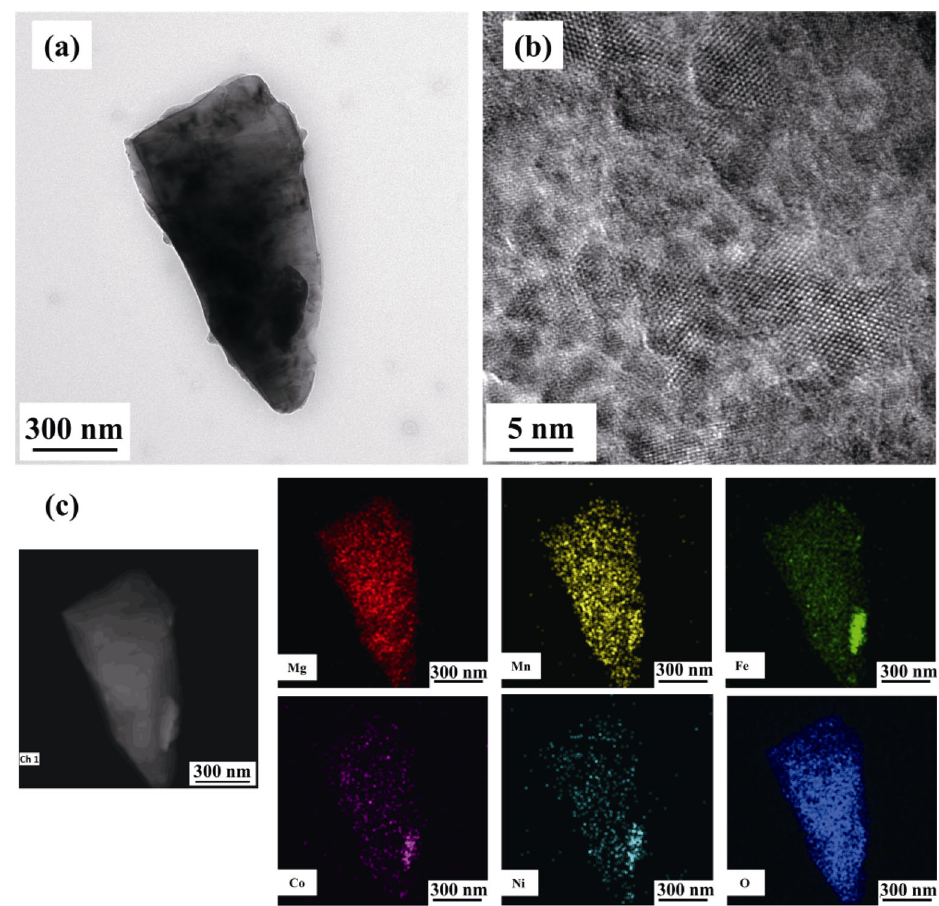
Fig. 5 (a) TEM image, (b) HRTEM image, and (c) scanning transmission electron microscopy (STEM) image and EDS mappings of (Mg 0.2 Mn 0.2 Fe 0.2 Co 0.2 Ni 0.2 )Fe 2 O 4 . Table 3 Saturation magnetization and coercivity